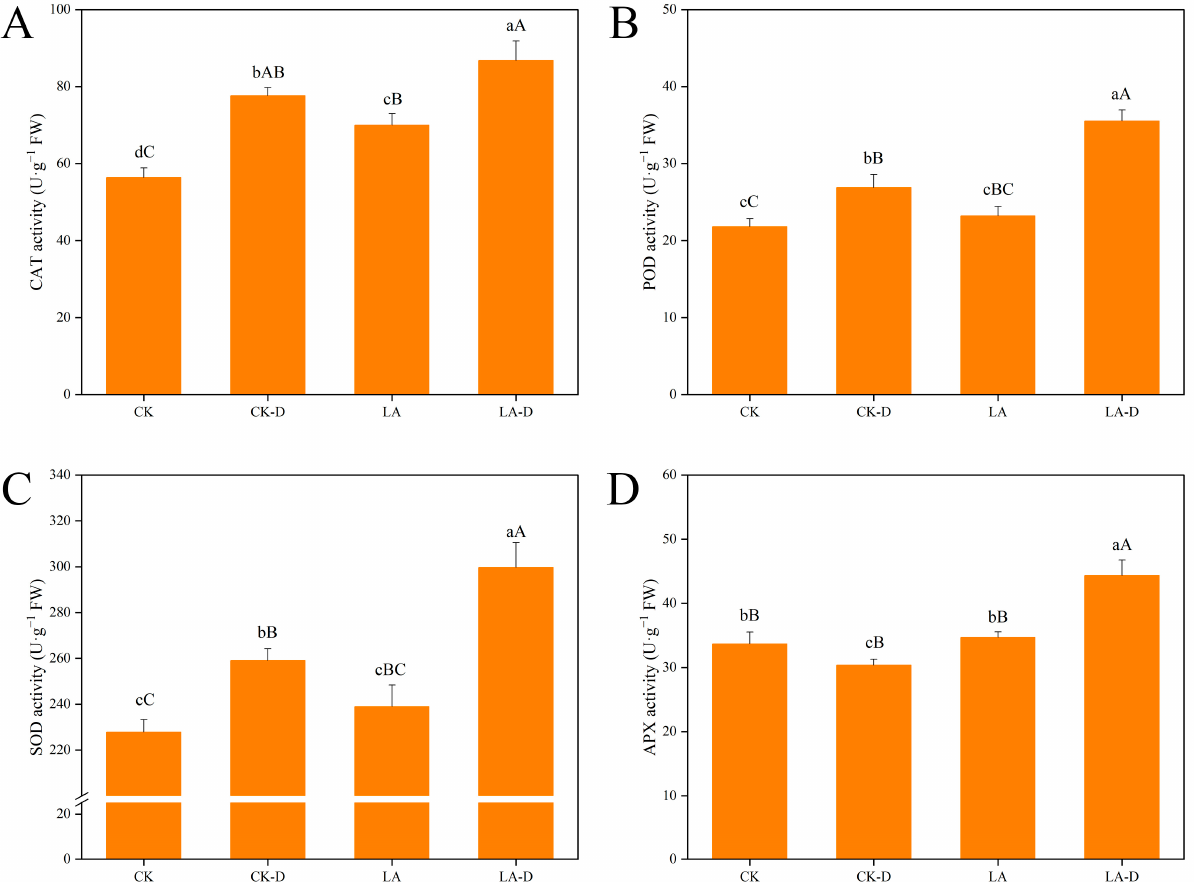
Figure 5. Effects of LA on antioxidant enzyme activity P. persica leaves under drought stress. ( A ) Catalase (CAT) activity, ( B ) peroxidase (POD) activity, ( C ) superoxide dismutase (SOD) ac- tivity, ( D ) ascorbate peroxidase (APX) activity. Values represent means ± SD of three replicates. Different letters indicate significant differences according to Duncan’s multiple range tests.